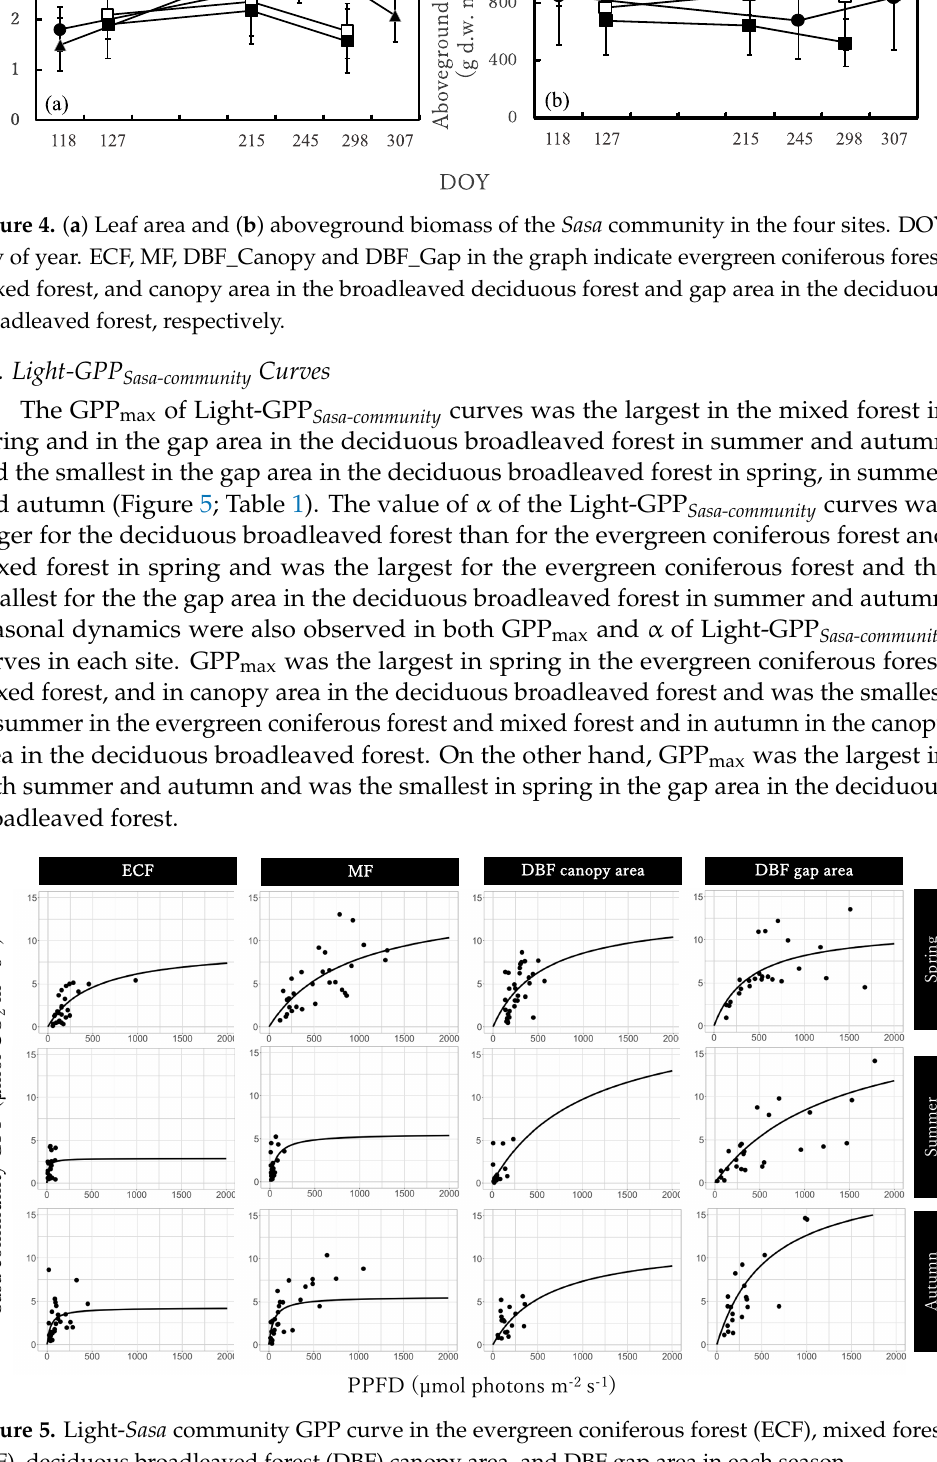
7 of 16 Figure 3. Daily cumulative photosynthetic photon flux density (PPFD) in the four sites during the growing period. DOY, day of year. 3.2. Seasonal Dynamics in the Sasa Community Leaf Area and Aboveground Biomass The leaf area was similar in the evergreen coniferous forest, mixed forest, and de- ciduous broadleaved forest in spring and was larger in the evergreen coniferous forest and mixed forest in summer and autumn (Figure 4a). It increased from spring to sum- mer and then decreased in autumn in the evergreen coniferous forest and deciduous broadleaved forest, while it increased from spring till the end of the growing season in